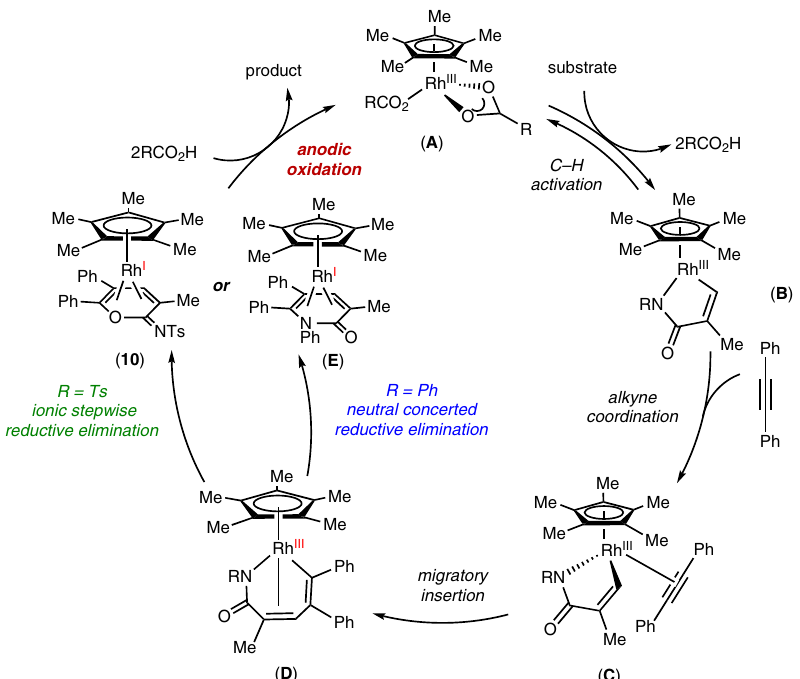
Fig. 9 Plausible catalytic cycle. The catalytic cycle starts from C – H activation, and then alkyne insertion leads to the seven-membered ring vinyl-rhodium intermediate D . Subsequently intermediate D undergoes either the classic neutral concerted reductive elimination to produce intermediate E , or the ionic stepwise pathway to produce complex 10 . Finally, product formation under anodic oxidation, and complex A is